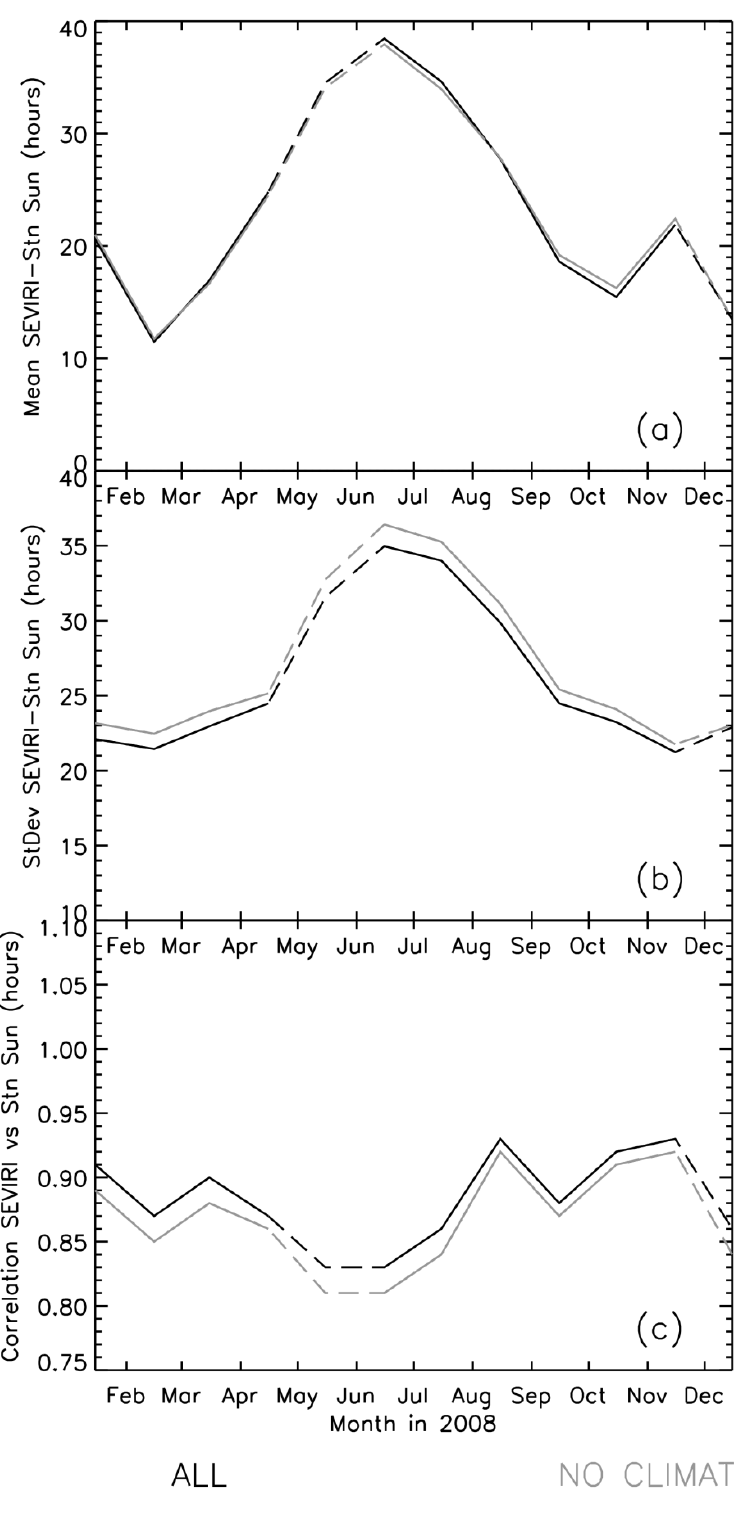
Figure 13. Annual cycles for the SD-SID product minus station sunshine duration monthly ( a ) mean differences and ( b ) standard deviation of differences. Panel ( c ) shows the corresponding SEVIRI vs . station correlations. Results are shown for validation using all available SYNOPS station data (black) and non-CLIMAT only stations (grey). For information, the unofficial monthly totals for May (five missing days) and December (nine missing days), are dashed in the plot due to missing